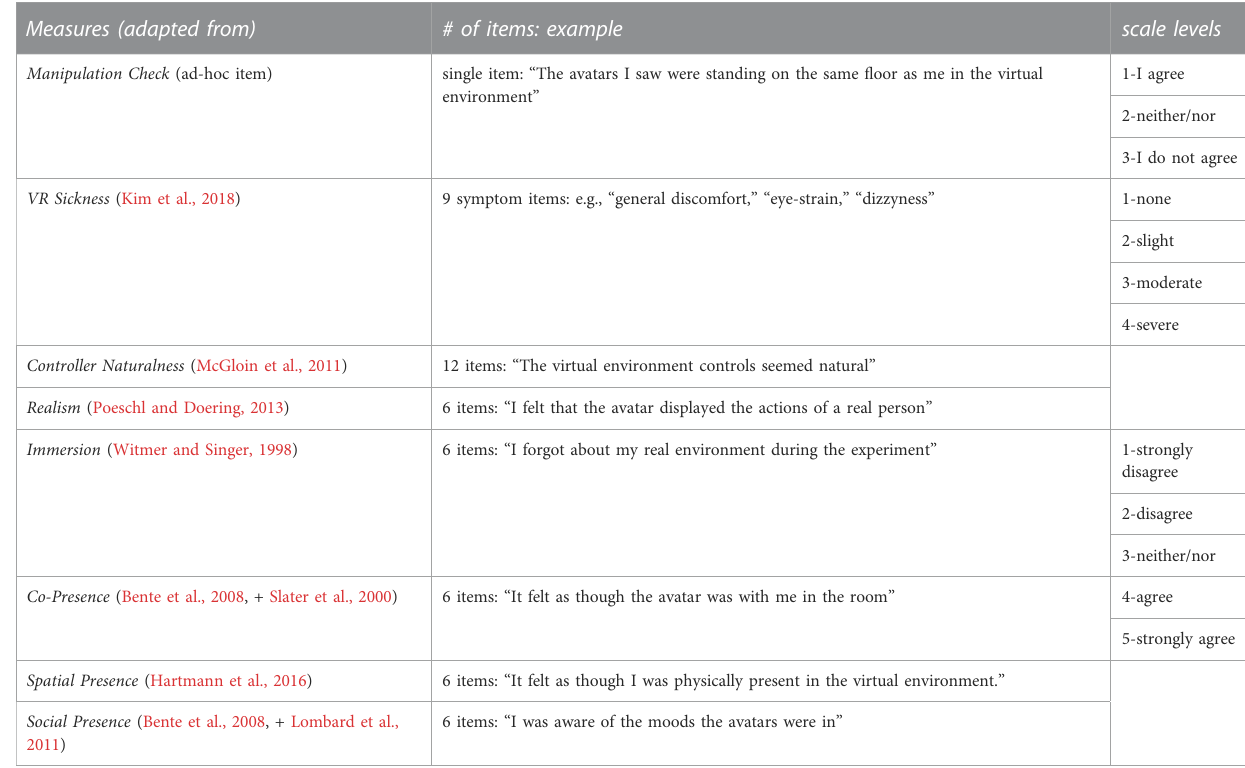
TABLE 1 Post-experimental measures. Measures (adapted from) # of items: example scale levels Manipulation Check (ad-hoc